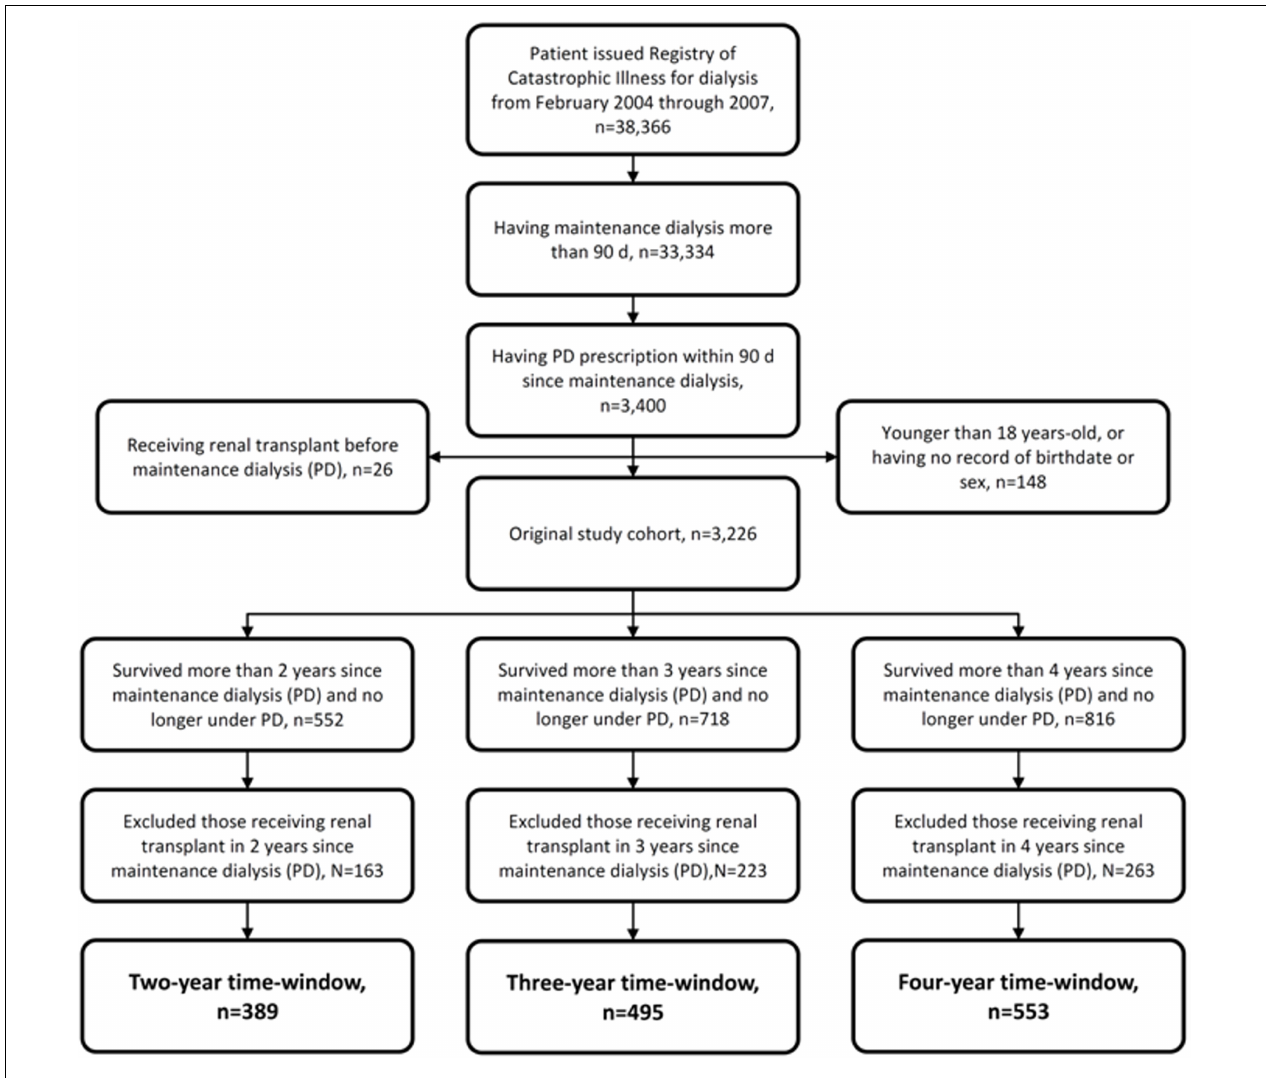
FIGURE 1 | Flowchart of patient enrollment in different fixed time-window